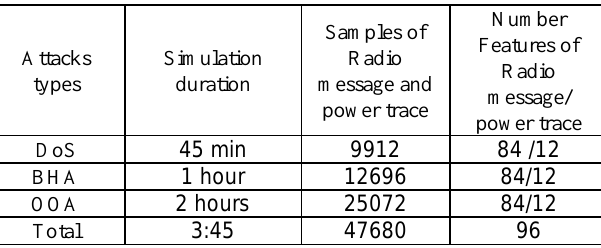
Table 2. Observations and features in each attack